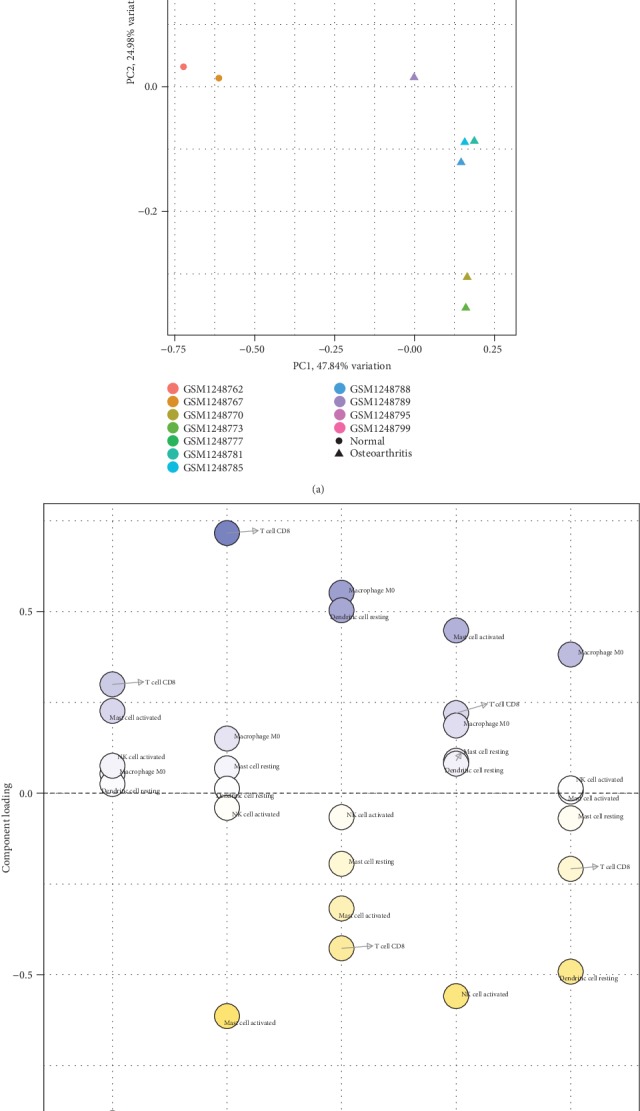
The diagnostic value of composition of infiltrating immune cells for osteoarthritis in subchondral bone. (a) Principle components analysis (PCA). (b) Component loading in PCA results.